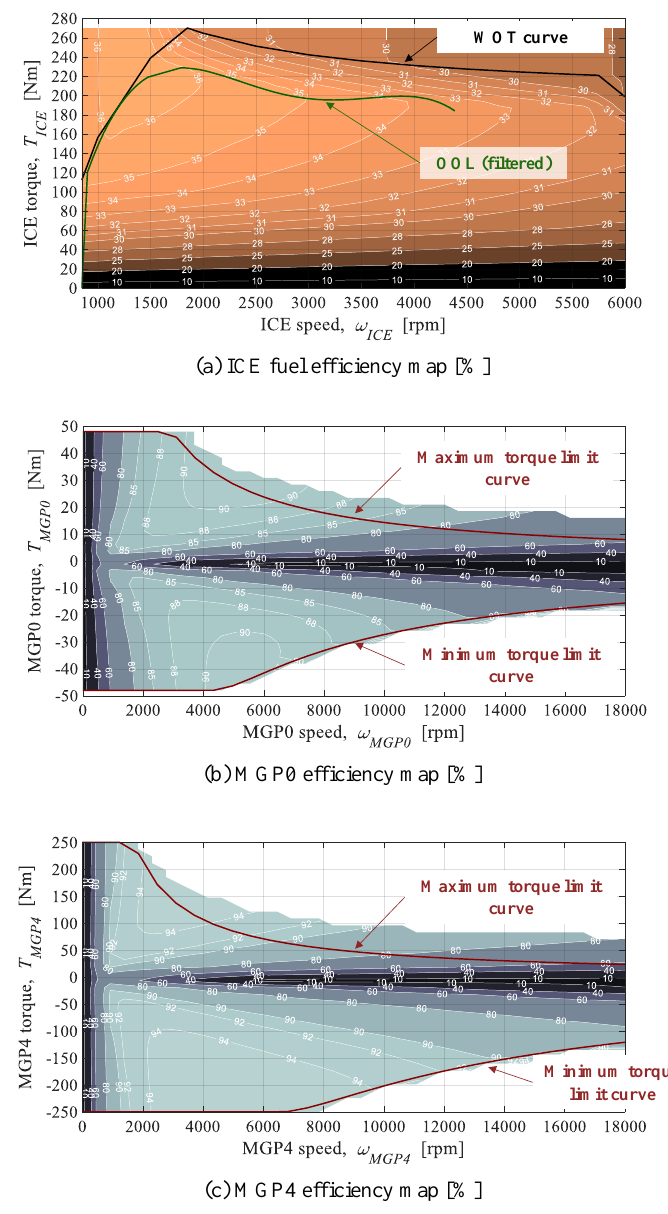
Figure 2. Efficiency maps of ICE, MGP0, and MGP4 generated by means of Simcenter Amesim ® software.